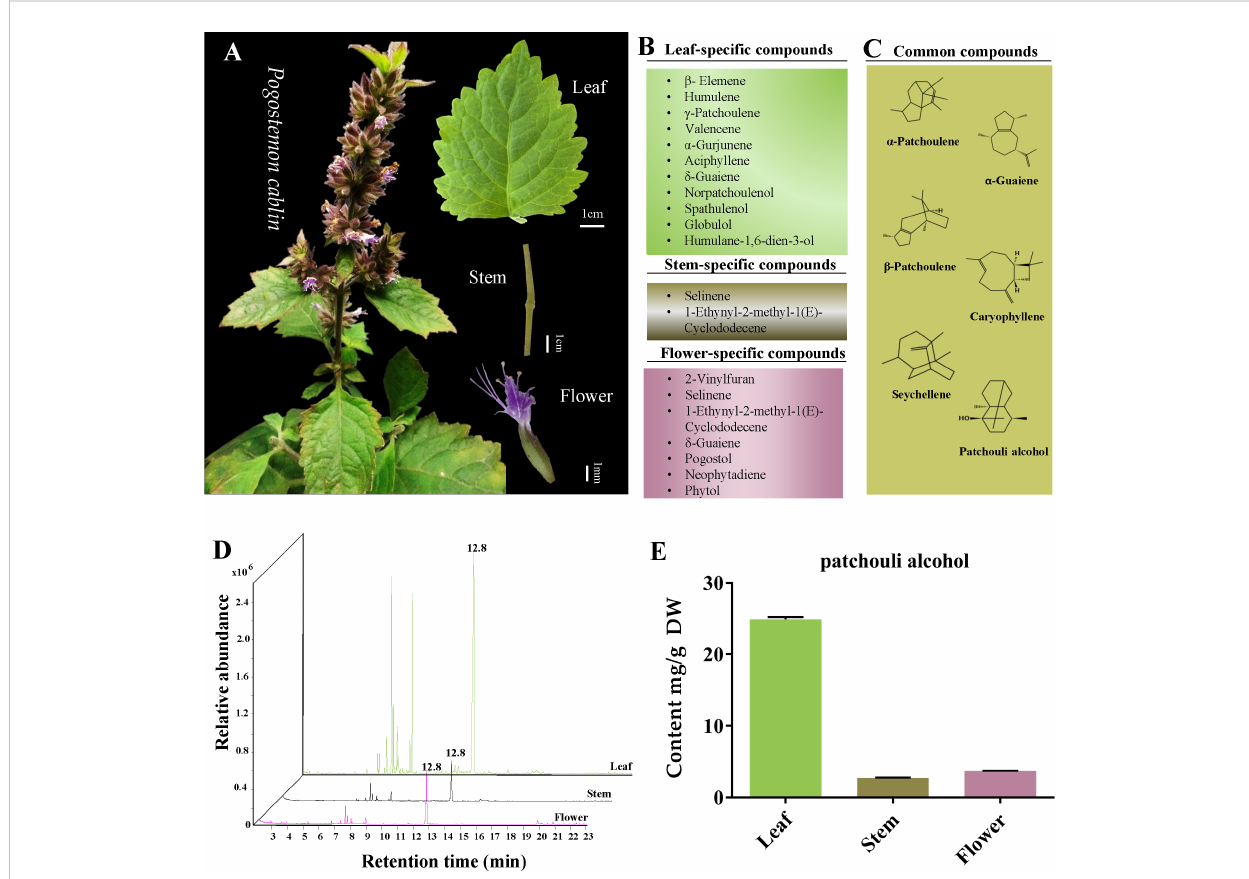
FIGURE 1 The tissue characteristics and volatile components analysis of Pogostemon cablin . (A) The phenotypic characteristics of P. cablin plants and their leaf, stem and fl ower. (B) Speci fi c compounds in leaf, stem and fl ower. (C) Common compounds in leaf, stem and fl ower. (D) Gas chromatography- mass spectrometer (GC-MS) chromatograms of samples from the leaf, stem and fl ower, the retention time of patchouli alcohol is 12.8 min. (E) The content of patchouli alcohol in leaf, stem and fl ower. Error bars represent 95% con fi dence intervals. DW stands for dry